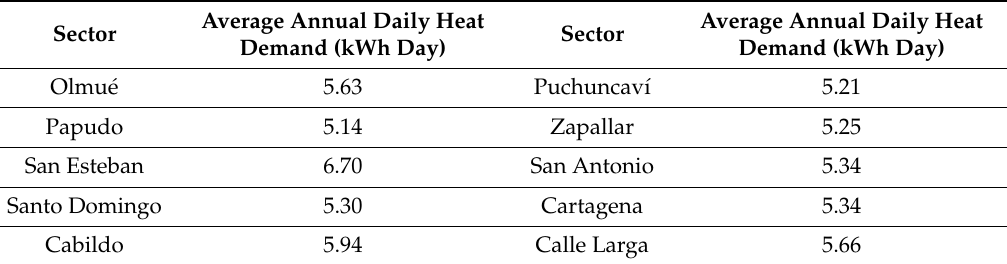
Table 4. Energy consumption for sanitary hot water (SHW) for single-family homes with four